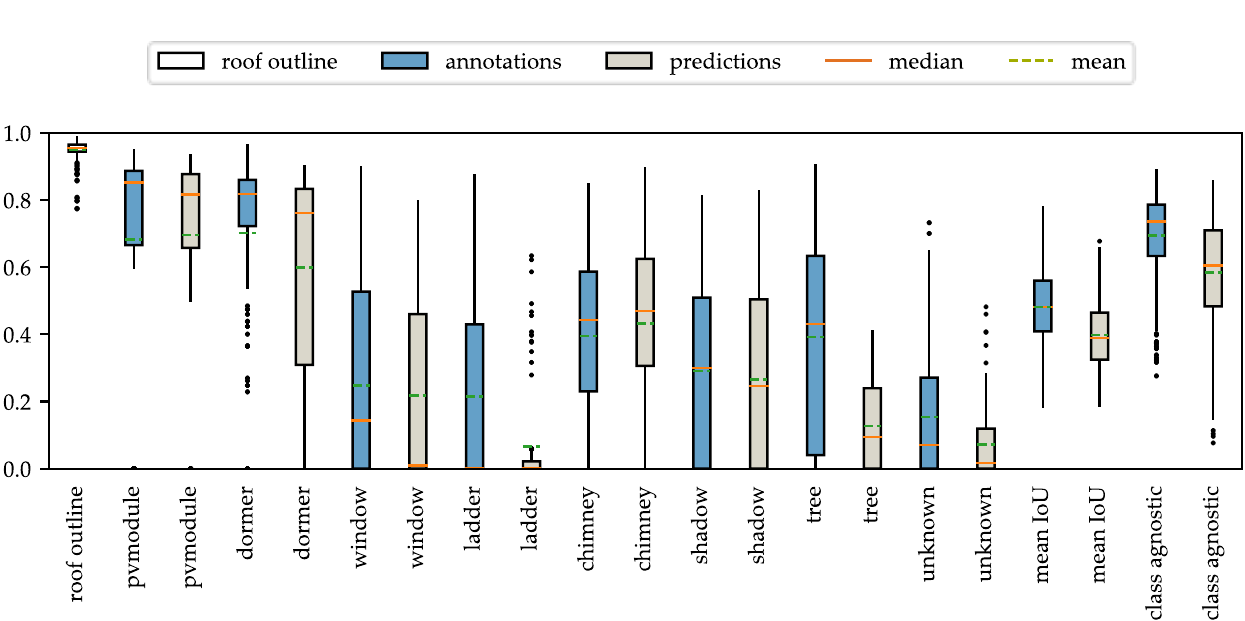
Figure 6. Boxplot of class-specific mean IoUs from the annotation experiment compared to the mean IoUs of the U-Net.